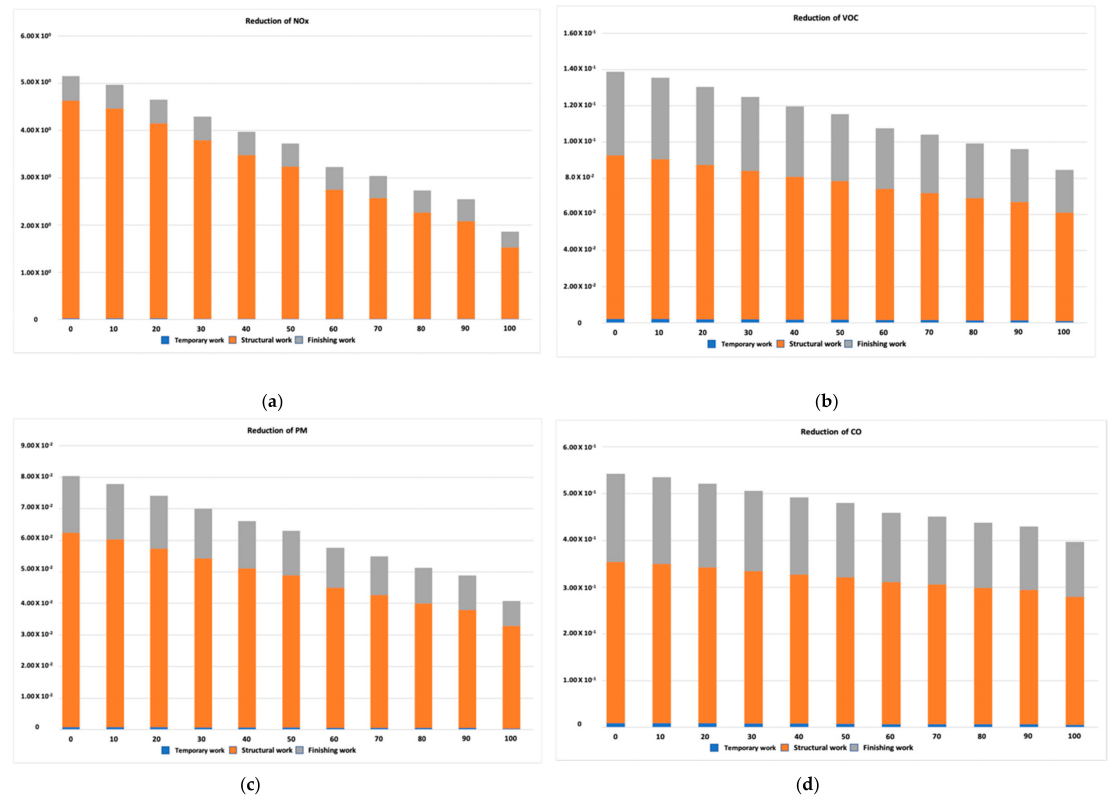
Figure 2. Reduction of the various road pollutants. ( a ) Reduction of NO x , ( b ) reduction of VOC, ( c ) reduction of PM, ( d ) Reduction of